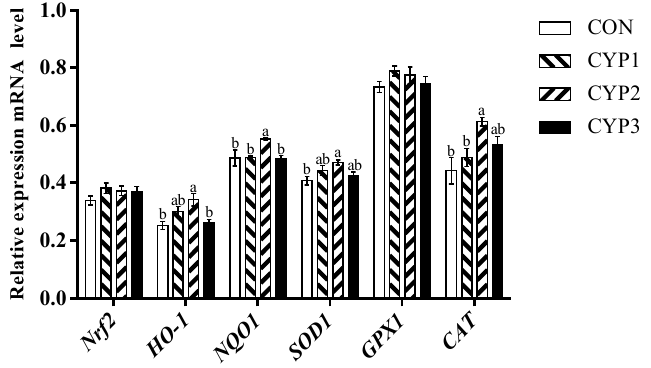
Figure 3. The Nrf2 , HO-1 , NQO1 , SOD1 , GPX1 , and CAT mRNA expressions of thigh muscle in broilers. Different lowercase superscripts indicate significant differences ( p < 0.05). CON = control diet; CYP 1 = control diet adds 250 mg CYP per kilogram; CYP 2 = control diet adds 500 mg CYP per kilogram; CYP 3 = control diet adds 1000 mg CYP per kilogram. Nrf2 , nuclear factor-erythroid 2- related factor 2; HO-1 , heme oxygenase 1; NQO1 , quinone oxidoreductase; SOD1 , superoxide dis- mutase 1; GPX1 , glutathione peroxidase 1; CAT , catalase.